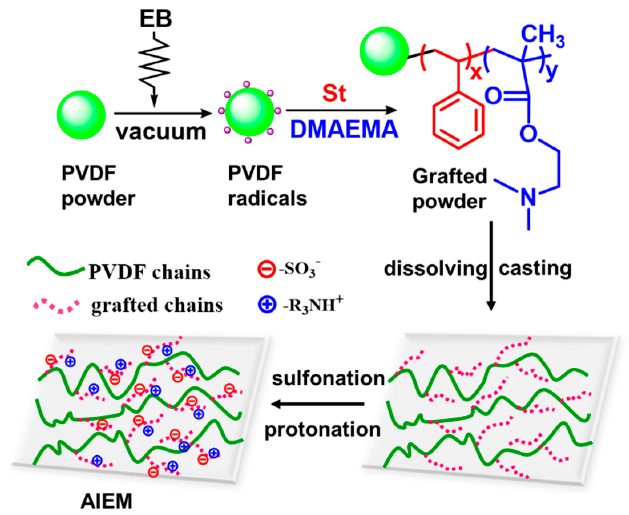
Figure 1. Schematic illustration of preparation of the amphoteric ion exchange membrane (AIEM).